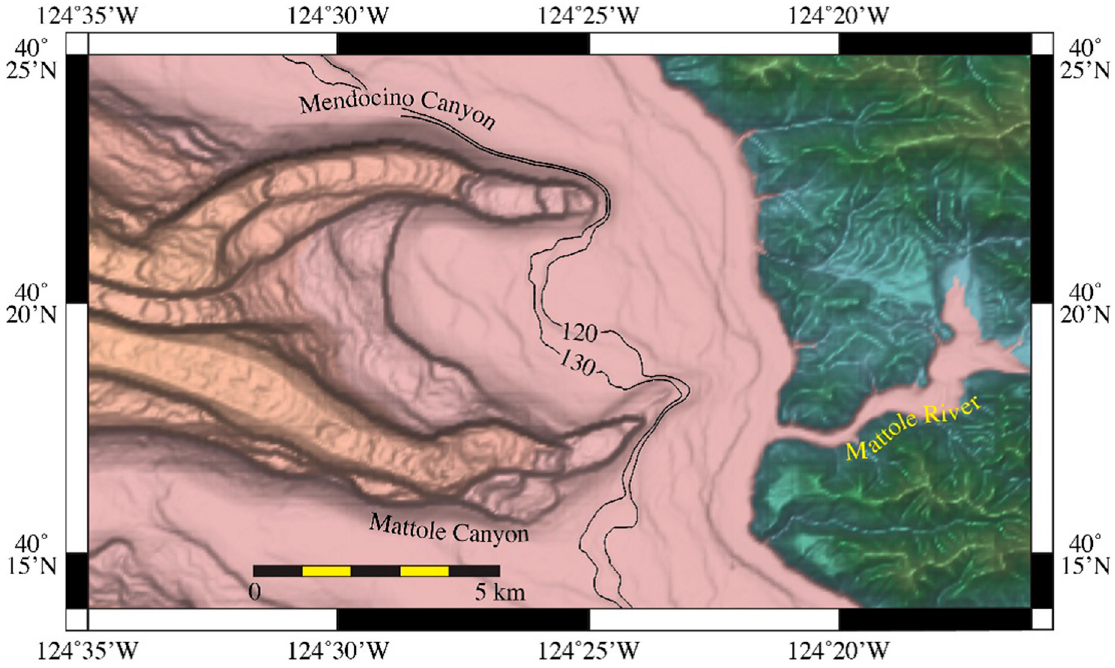
Figure 16. Map view of Coastal Relief Model bathymetry of heads of Mendocino and Mattole Canyons. The 120 and 130 m isobaths represent the range of the shoreline at the glacial maximum isostatic low stands of eustatic sea level. See Figure 2 for location.